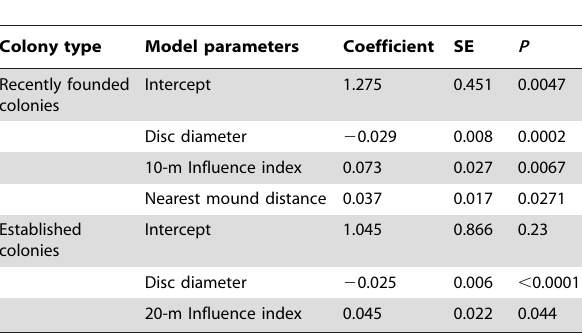
Table 2. Best-fitting logistic regression models of 2008–2009 mortality risk for recently founded ( n =162) and established rough harvester ant colonies ( n = 204).